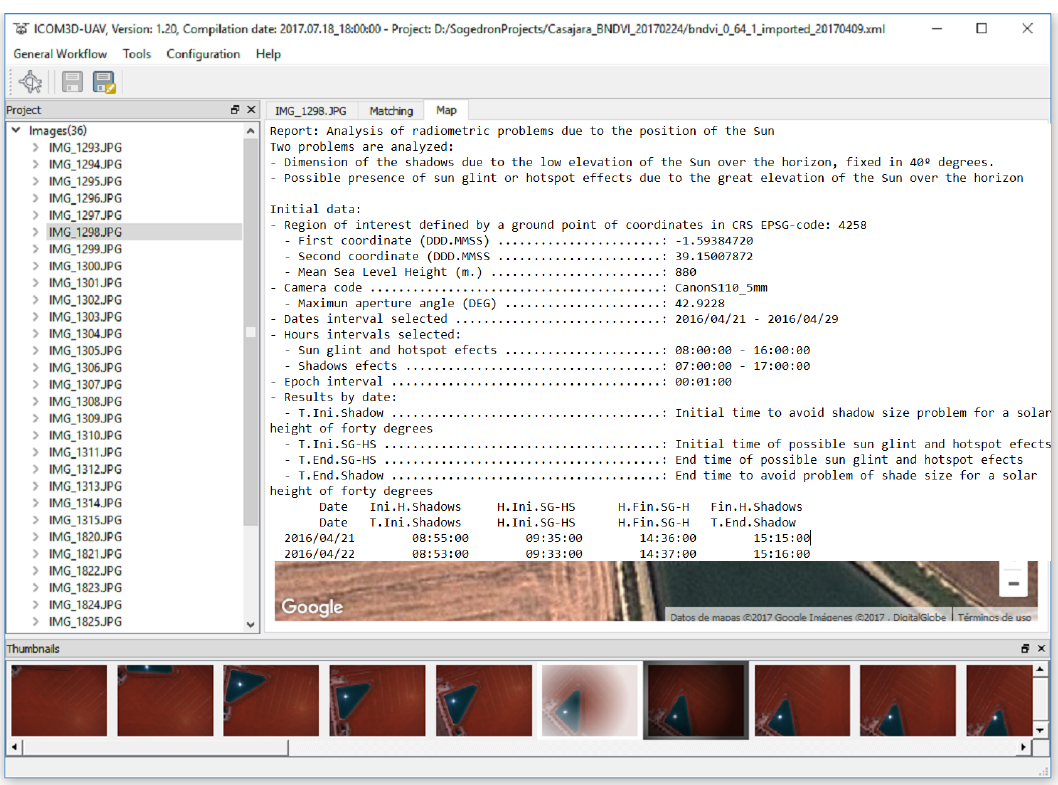
Figure 7. Detailed report about the interval time for possible hotspot/sun glint effects. Note that the time interval for sun glint and hotspot effects are broad since we are using a digital camera with a large field of view.